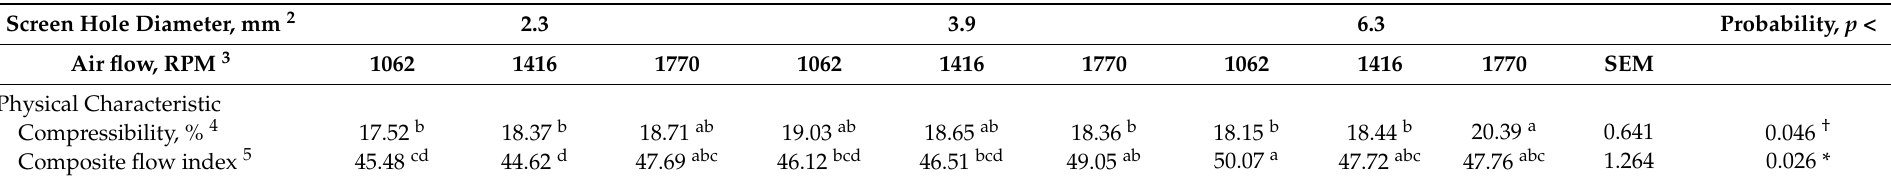
Table 3. Influence of 2-way interaction of screen hole diameter × air flow on the compressibility and composite flow index of hammermilled corn 1 . Screen Hole Diameter, mm